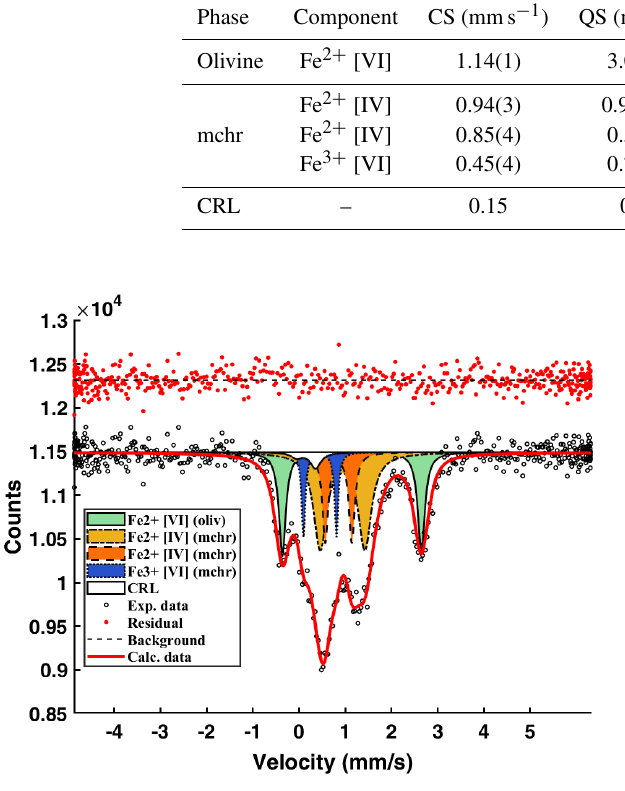
Figure 2. Energy-domain SMS spectrum of the studied mchr– olivine inclusion pair showing the contribution of both crystals. Fe 2 + [VI] (oliv) denotes octahedrally coordinated Fe 2 + in olivine; Fe 2 + [IV] (mchr) denotes tetrahedrally coordinated Fe 2 + in mchr; Fe 3 + [VI] (mchr) denotes octahedrally coordinated Fe 3 + in mchr; CRL denotes compound refractive lens; Exp. data denotes exper- imental data; Calc. data denotes calculated data. Total absorption ∼